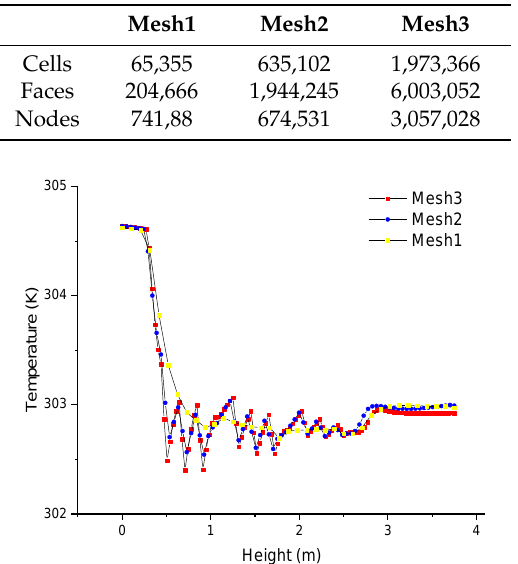
Table 1. Information on the meshes in the sensitivity tests.